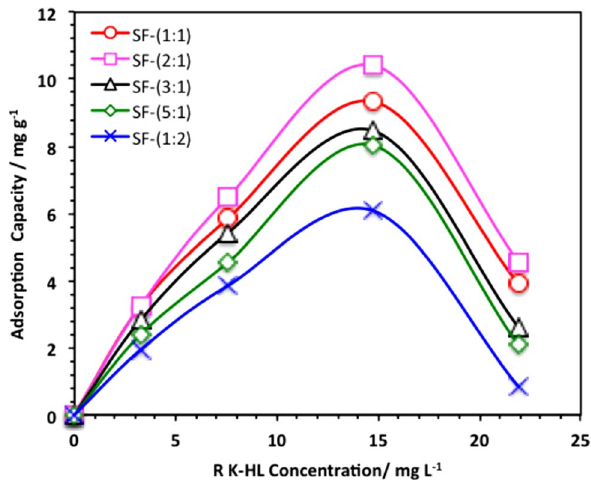
Fig. 7 Effect of initial Red K-HL dye concentration load on the adsorption